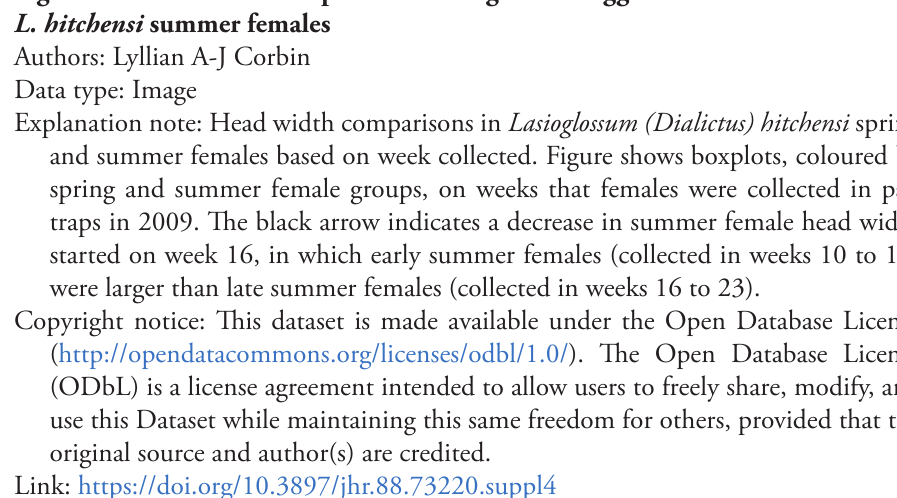
Figure S4. Head width comparisons among weeks suggest a mix of social traits